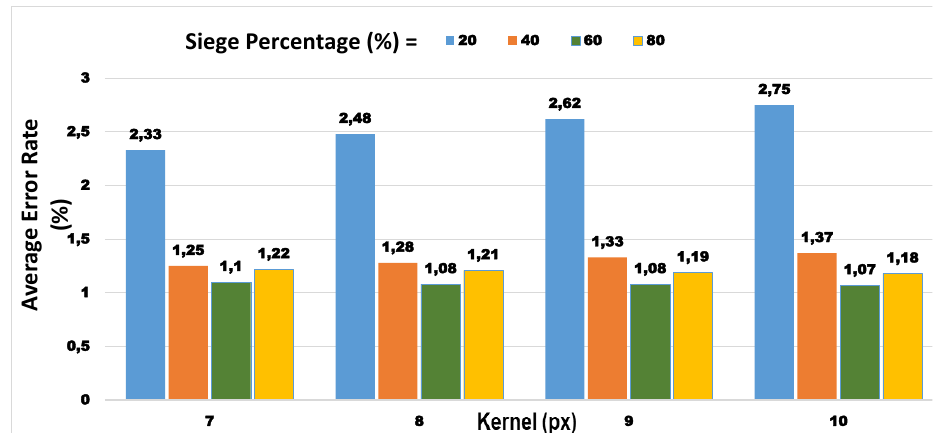
Figure 11. Average system error rate with kernel values between 7 and 10, and Siege Percentage Thresholds equal to 20%, 40%, 60%, and